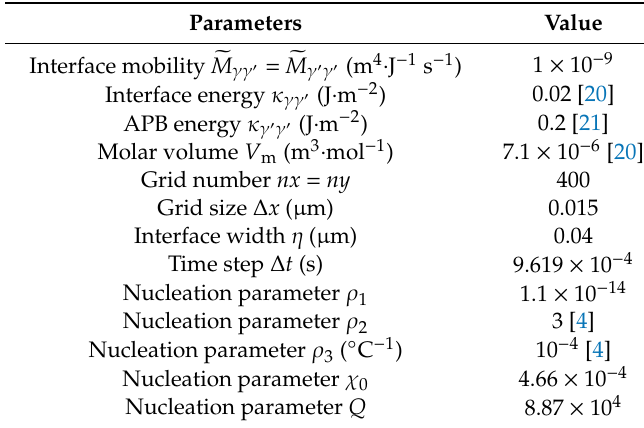
Table 4. Nucleation and phase-field